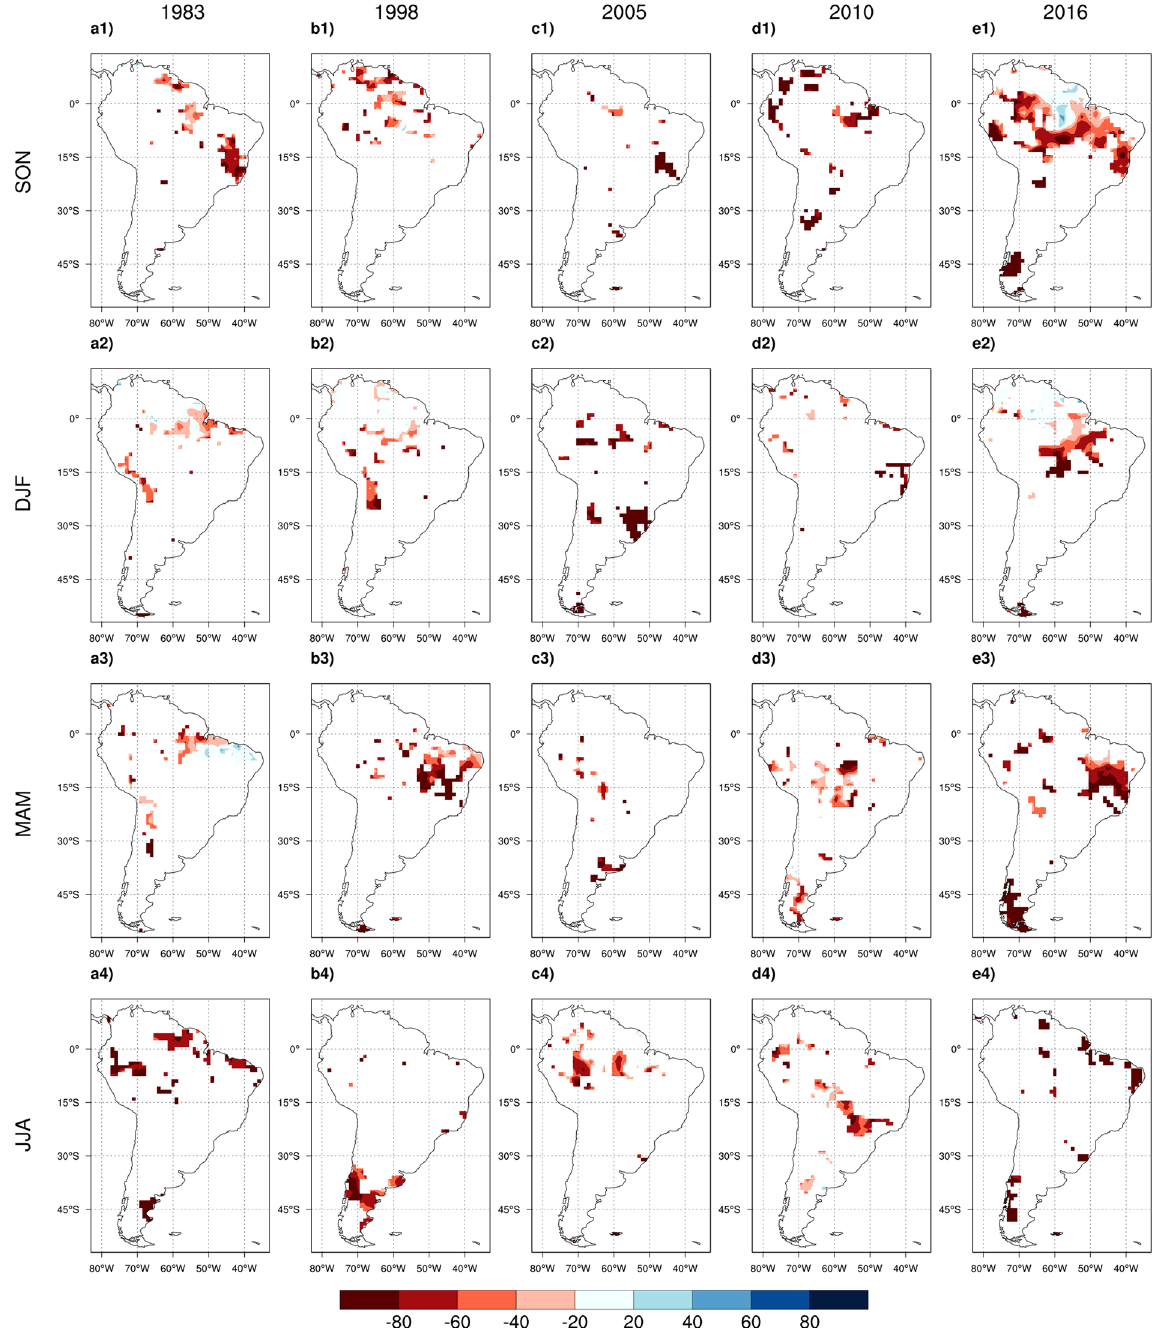
Figure 6. Spatial maps of model relative biases in predicting the magnitude of precipitation anomalies for the five extreme droughts of 1983 ( a1 to a4 ), 1998 ( b1 to b4 ), 2005 ( c1 to c4 ), 2010 ( d1 to d4 ), and 2016 ( e1 to e4 ). The areas where magnitude of the observed negative standardized anomalies of precipitation is lower than 1.0 are masked out in order to only focus on regions that experience intense drought. Here, the least-square fit is implemented over the entire analysis period (1982–2017) to equally account for all five extreme droughts when deriving the regression coefficients of the multivariate linear model. Seasonal cycles for each year start from September of the previous year (e.g. SON 2004 for 2005 seasonal cycle). Figures created with: The NCAR Command Language (Version 6.3.0) [Software]. (2016). Boulder, Colorado: UCAR/NCAR/CISL/TDD.